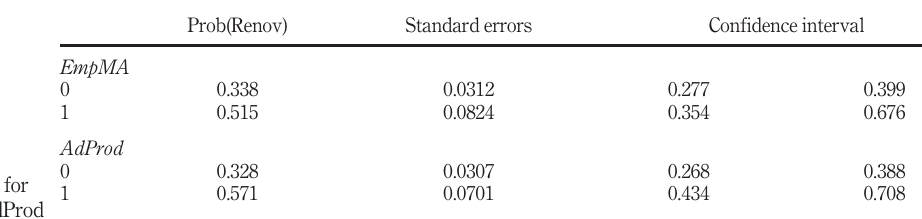
Table VIII. Marginal effects for EmpMA and AdProd rates